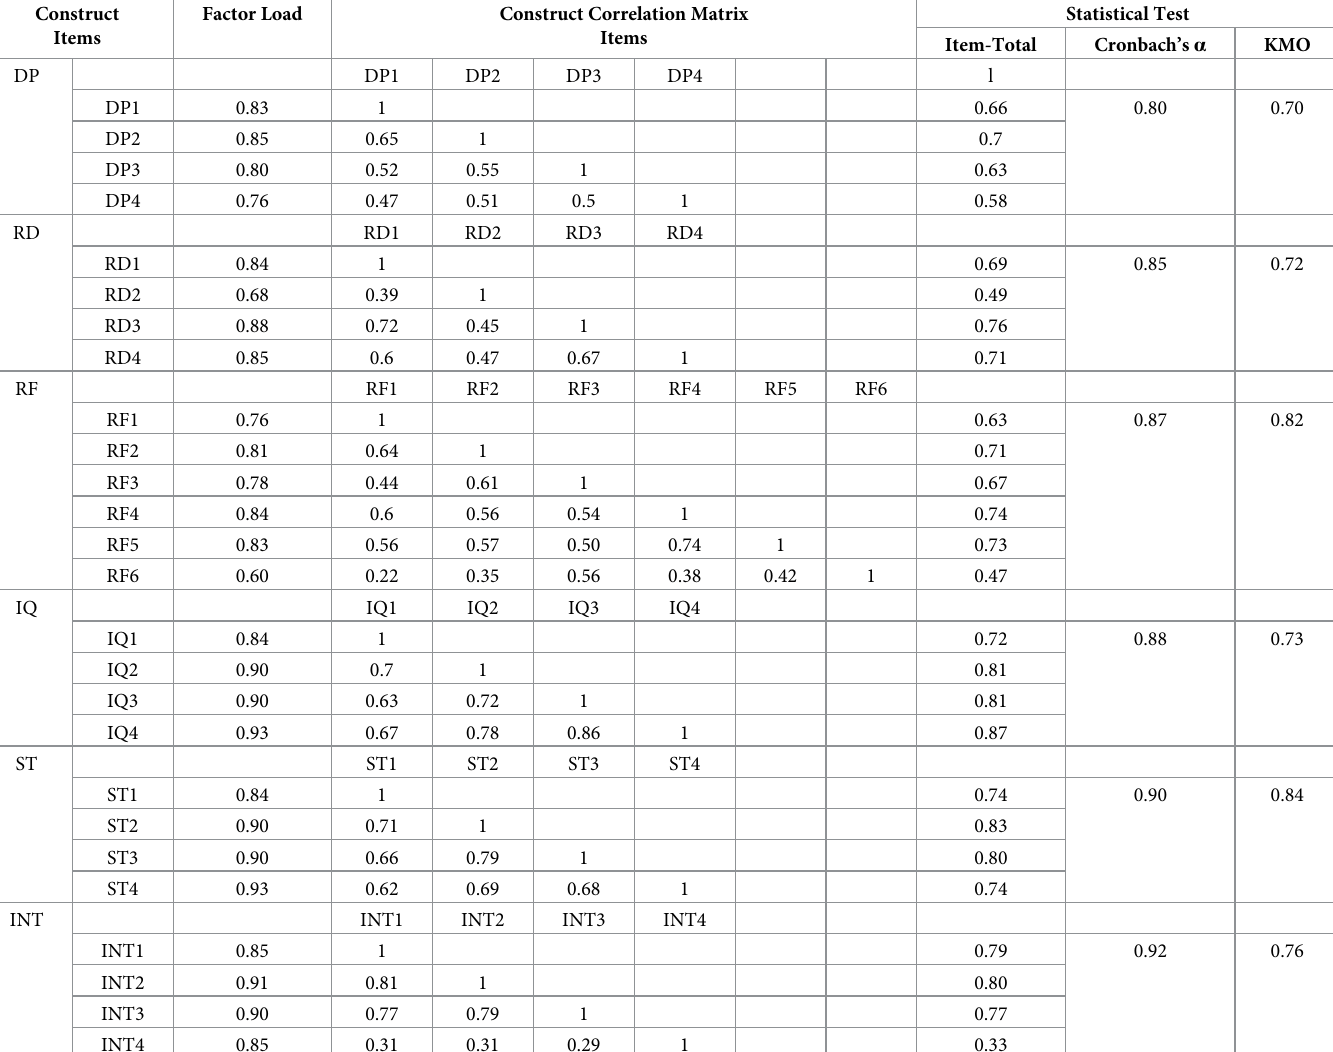
Table 3. Result of the confirmatory factor analysis and composite reliability. Construct Items